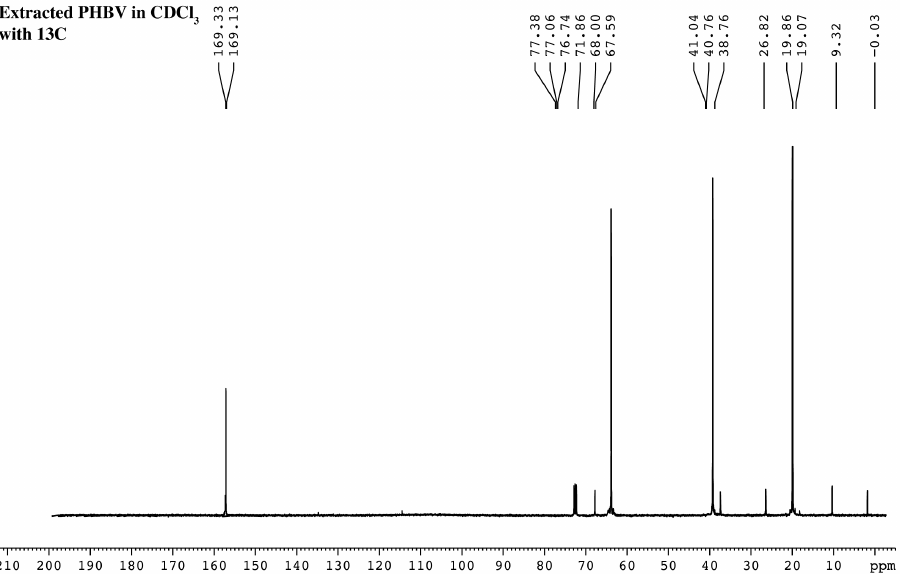
Figure 9. 13 C-NMR spectrum of the PHBV extracted from Cyanosarcina sp. AARL T020.